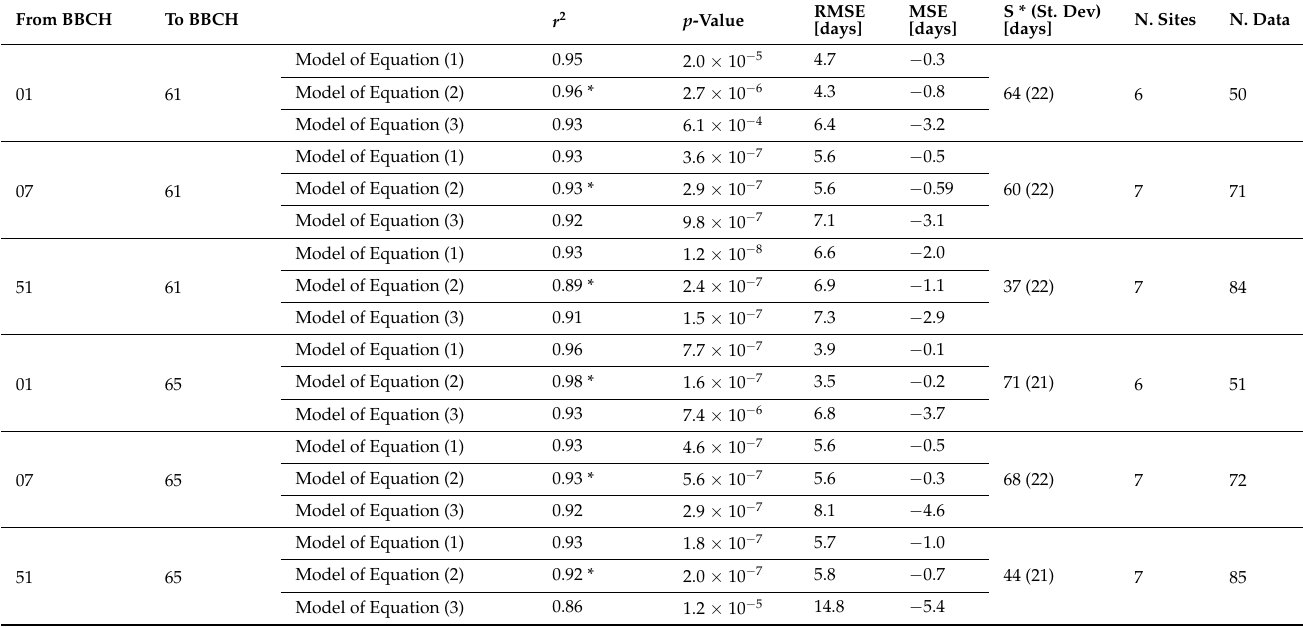
Figure 4. Simulated vs. observed phases time lengths for the cross-validated phases (subplots’ headline) using a linear DR function. Black line: least square line; dotted black line: 1:1 line. Statistical evaluation reported in Table 3 (Model of Equation (1)). Definition of BBCH in Table 2. Symbols in the legend refer to the location of the experimental site (Table 1). Table 3. Statistical evaluation of simple DR s (Equation (4)) obtained from the KfCV for selected phases. S * = mean observed phase time length; RMSE = Root Mean Square Error [d]; r 2 = coefficient of determination (* = adjusted r 2 ); MBE = Mean Bias Error